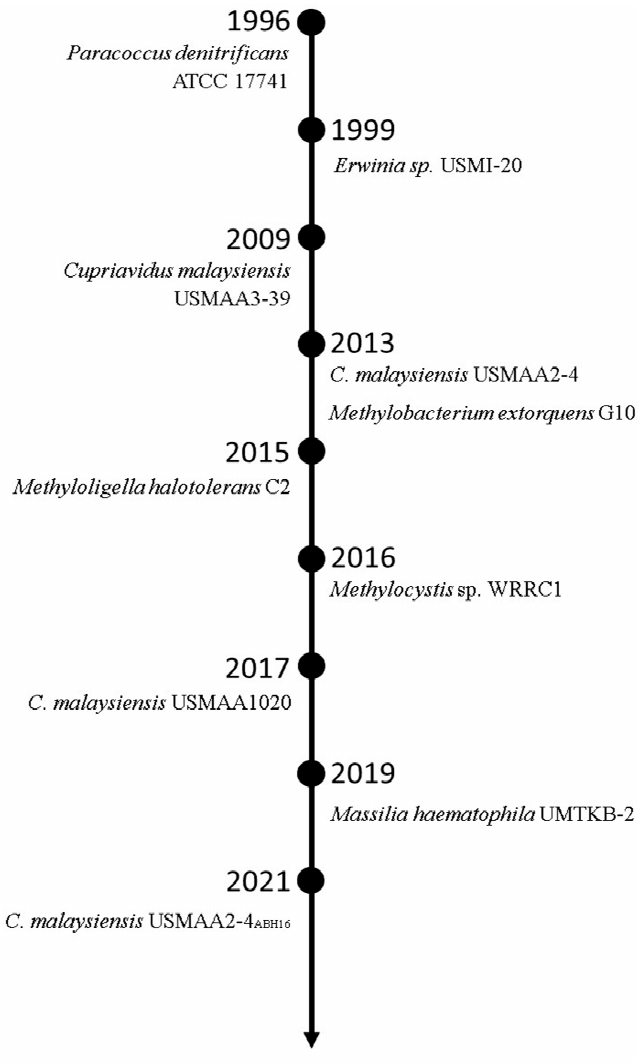
Figure 12. Timeline of the emergence of alkyl alcohol-tolerant P(3HB- co -3HV)-producing